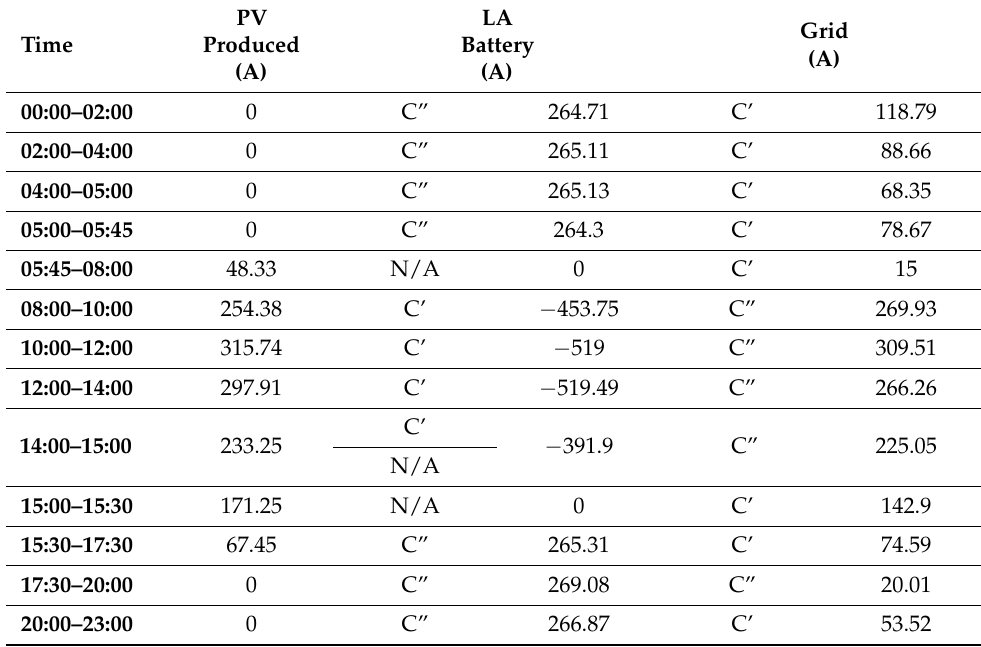
Table 4. Behaviour of power system electric resources